Question: Express in one sentence what the figure is showing.
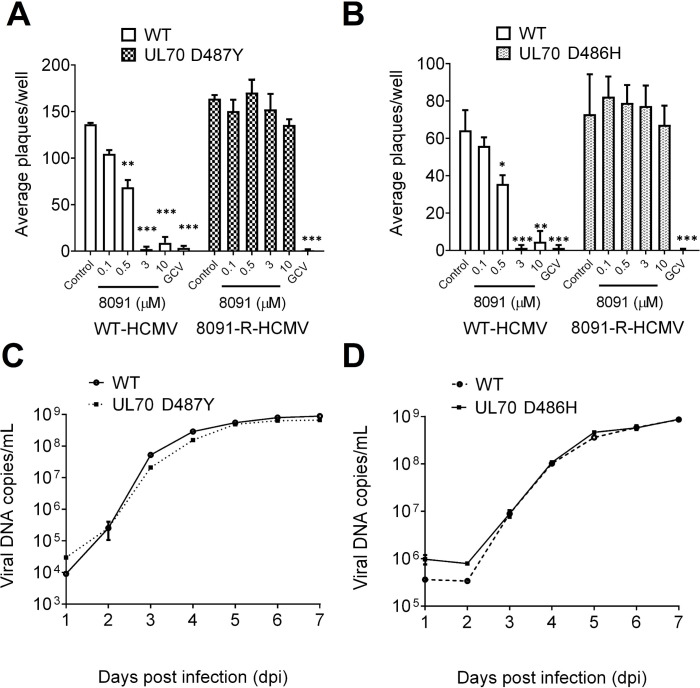
Answer: HCMV Towne, which harbors mutations in UL70, is not inhibited by MLS-8091 . ( A ) HFFs were infected with 150 PFUs of WT or MLS8091-resistant HCMV Towne SS-8091-R3 (UL70 D487Y) and treated with the indicated concentrations of MLS8091. Plaques were stained and counted after 10 days. Statistical significance is assessed against the infection-only (control) condition. ( B ) HFFs were infected with 100 PFUs of WT or MLS8091-resistant HCMV Towne, SS-8091-R3 (UL70 D486H), and treated with the indicated concentrations of MLS8091. Plaques were stained after 10 days. ( C ) HFFs were infected with WT or MLS8091-resistant HCMV Towne (UL70 D487Y) at an MOI of 0.1, and supernatants were harvested 1–7 days post-infection. Viral DNA load was quantified using real-time PCR for US17. ( D ) HFFs were infected with WT or MLS8091-resistant HCMV Towne (UL70 D486H) at an MOI of 0.1, and supernatants were harvested 1–7 days post-infection. Viral DNA load was determined by real-time PCR for US17.